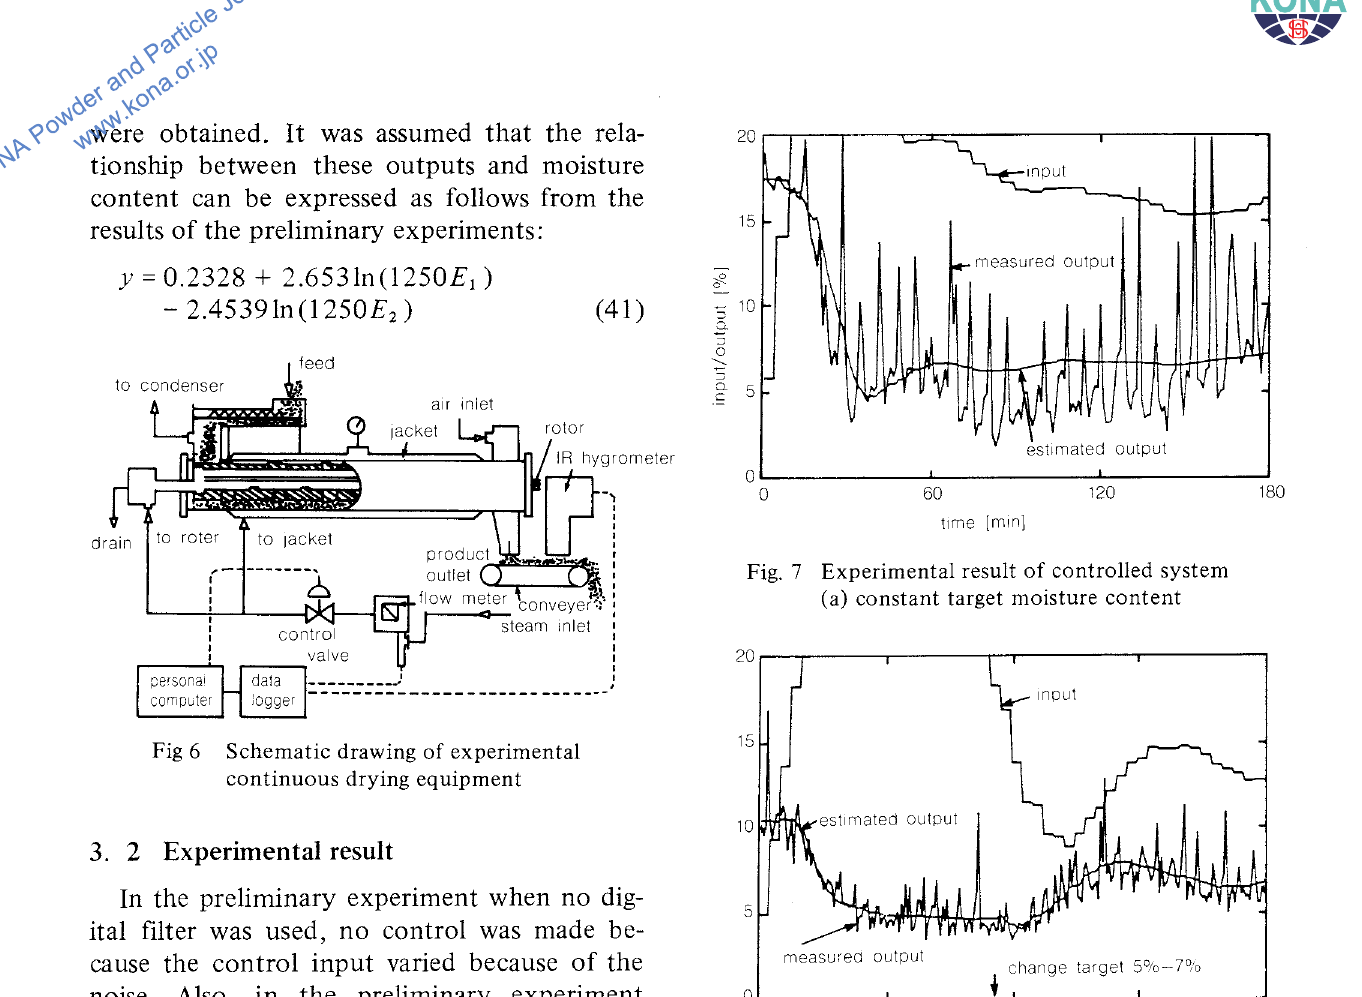
Fig 6 Schematic drawing of experimental continuous drying equipment